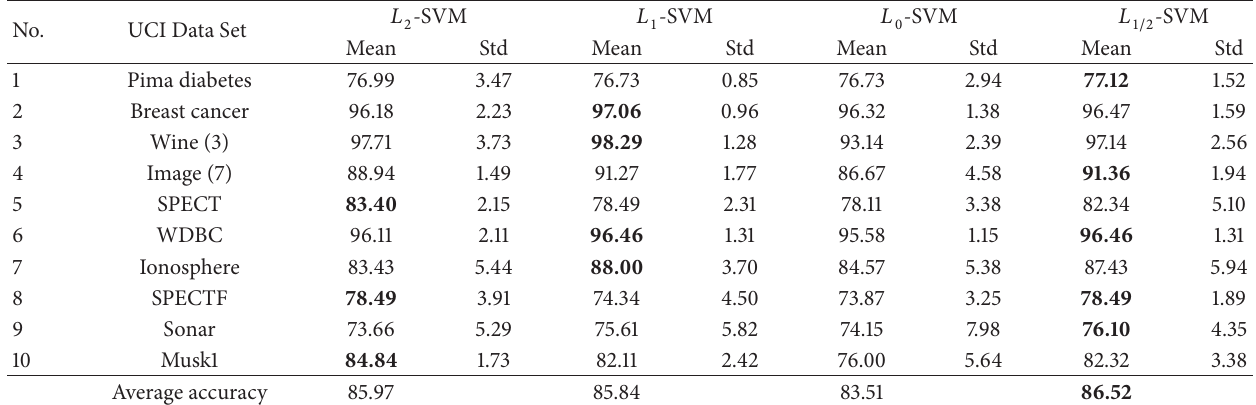
Table 5: Classification performance comparison on UCI data sets